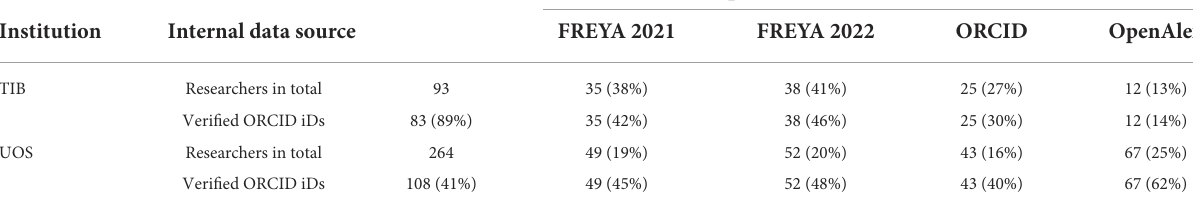
TABLE 1 ORCID coverage for selected open data sources for UOS and